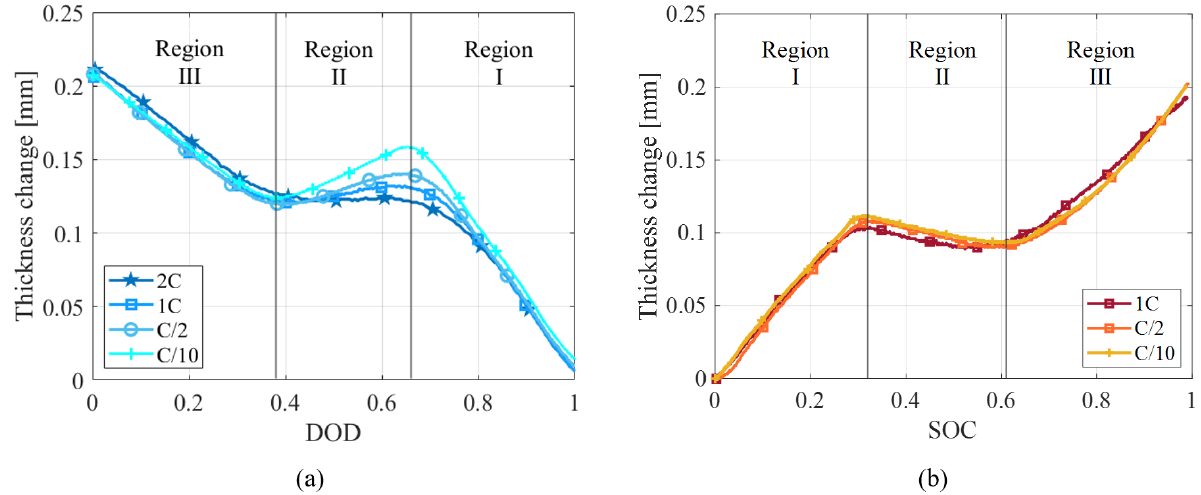
Figure 9. Thickness change during discharge ( a ) and charge ( b ) with different current rates.